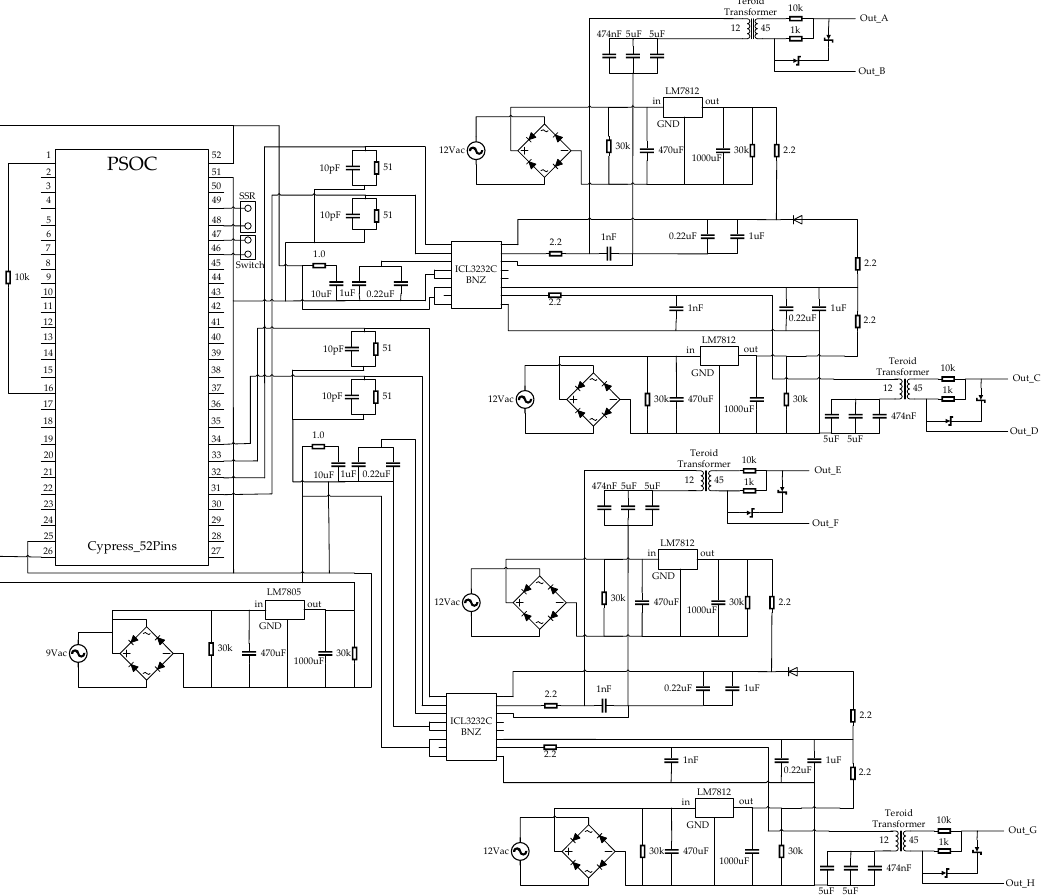
Figure 7. Schematic of how the set circuit generates and drives pulse signals. Based on this calculation, the final weight W f = 230 kg and the evaporated water was 500–230 kg, which equals 270 kg. Then, we used the amount of evaporated water to calculate the heat energy from Equation (2):